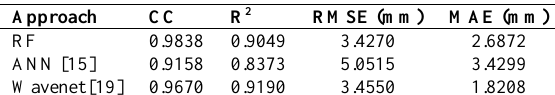
Figure 7. Measured vs. predicted MMS for RF model. Table 3. Results of statistical